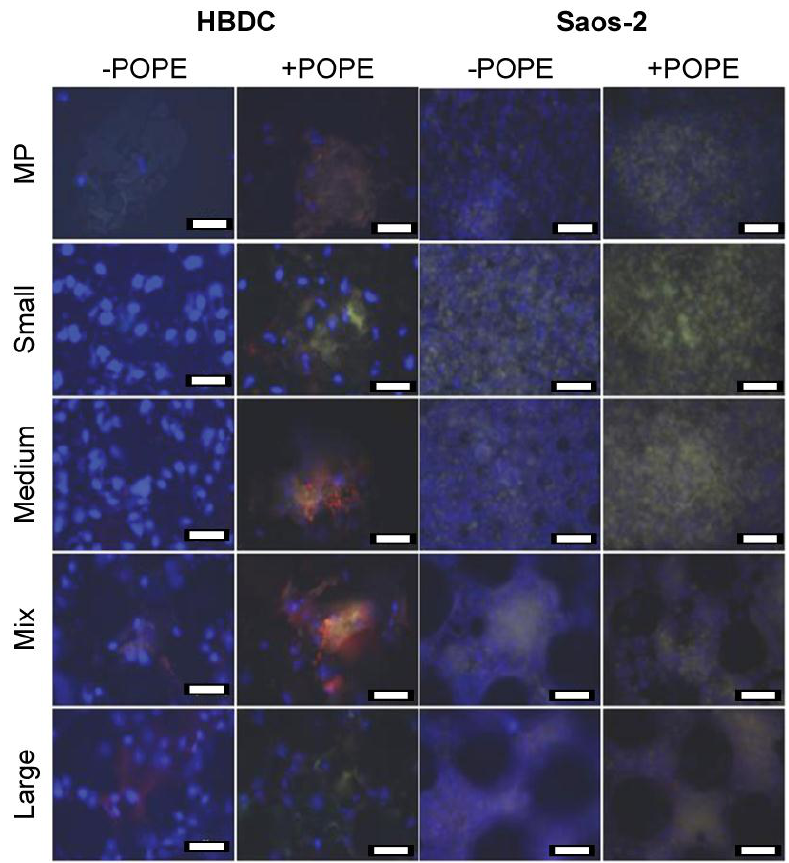
Figure 2. Immunocytochemistry. OC (green) and OPN (red) were targeted in HBDCs and Saos-2 cells on different POPE coated (+POPE) or not coated (−POPE) materials after 5 W. Due to the merged pictures, OC appears yellow. Nuclei were DAPI-stained and appear blue (scale bar 50 µm).